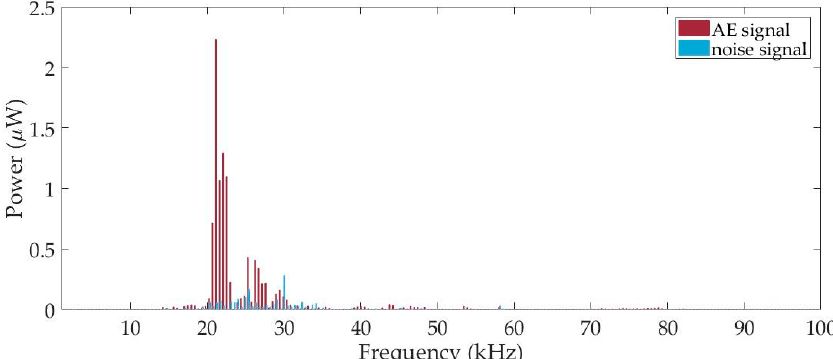
Figure 3. Averaged signal spectrum for 1000 recorded acoustic emission signals and measurement noise spectrum.